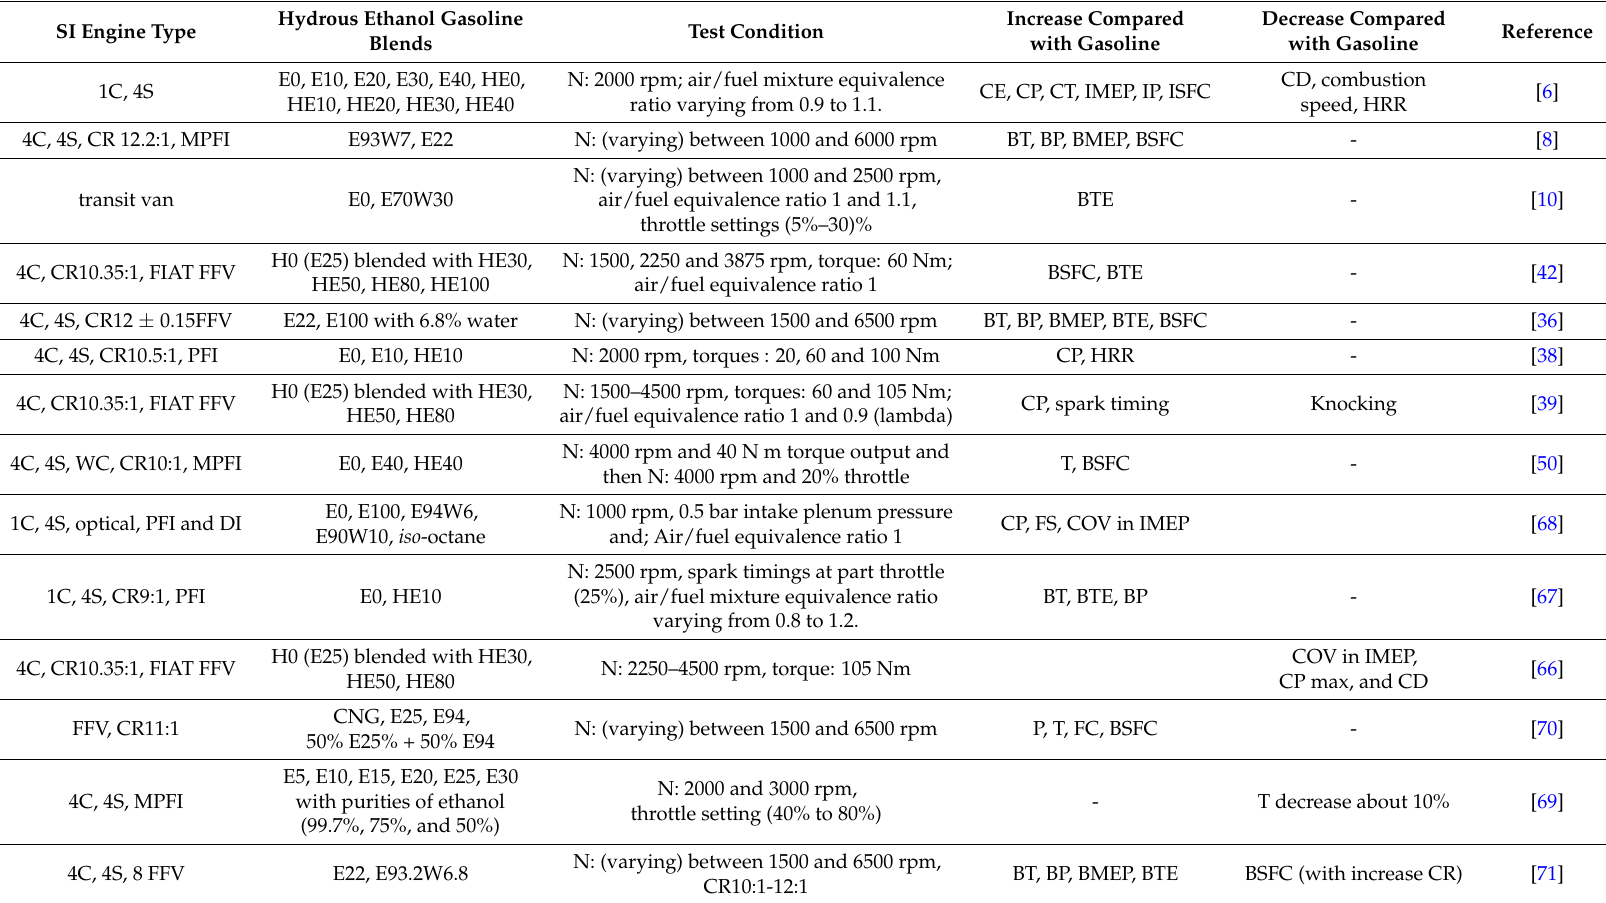
Table 3. Combustion and performance of hydrous ethanol fuel and its blends with gasoline in SI